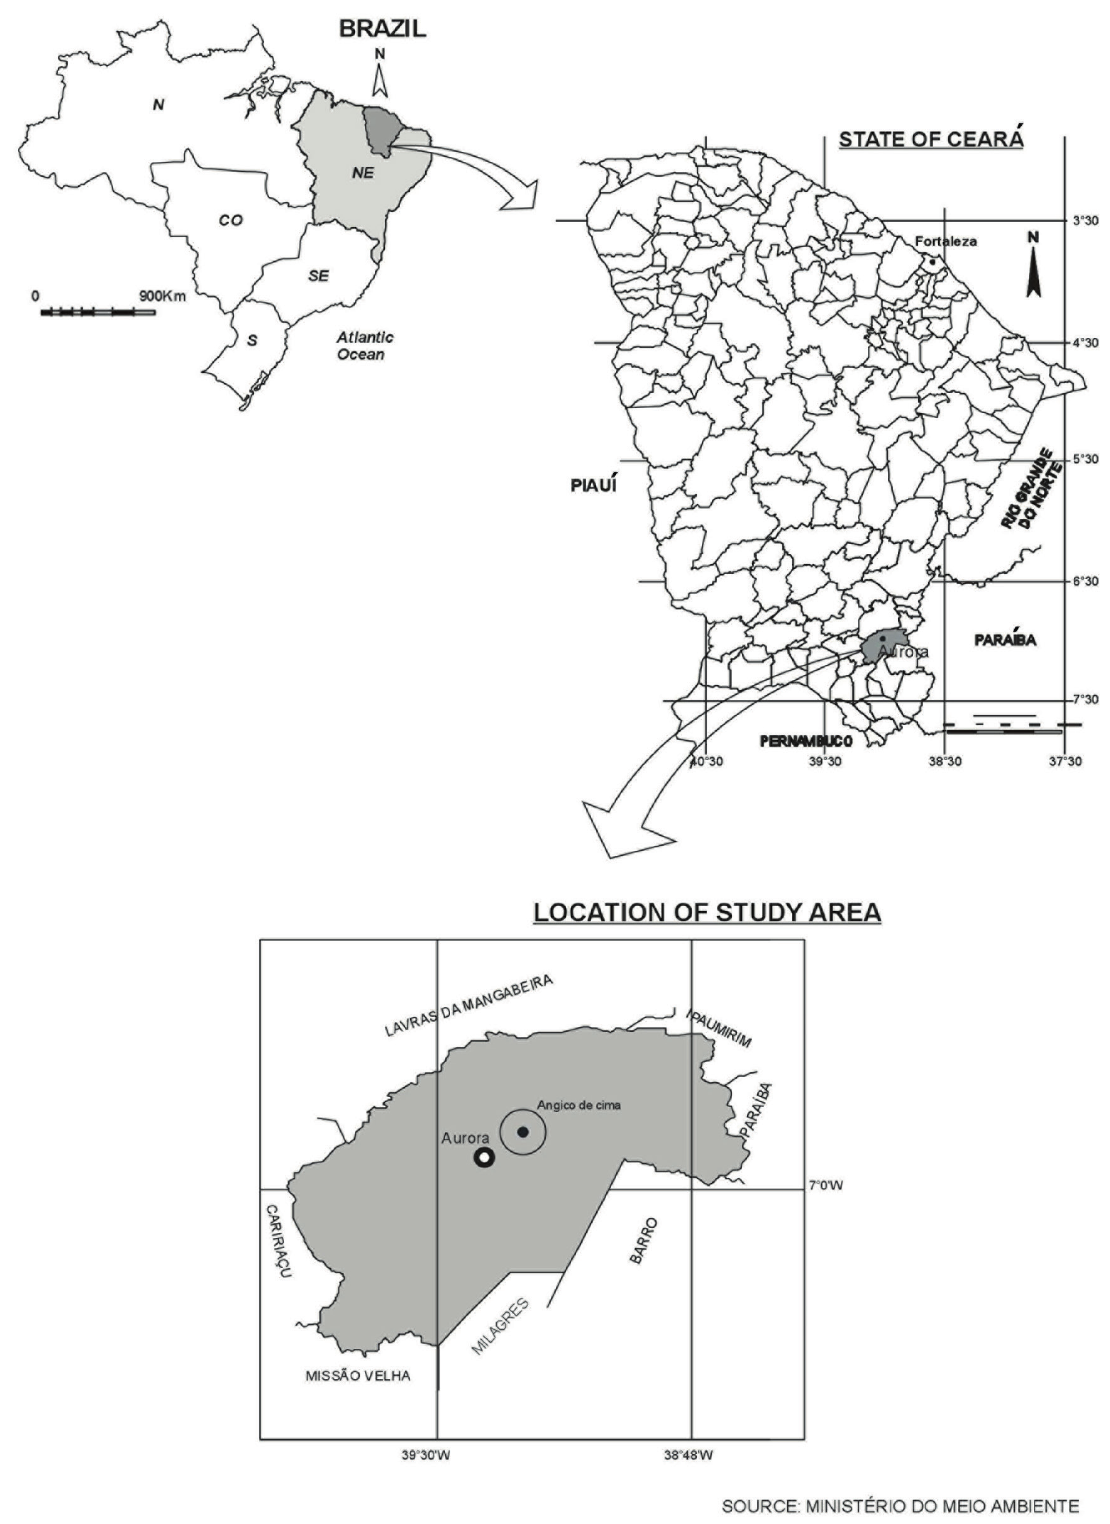
Figure 1 - Geographical location of the area of study in Angico de Cima community, in the city of Aurora, Ceará,